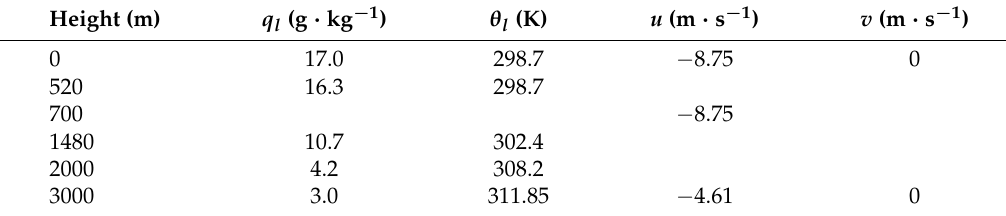
Table 2. Initial conditions set for the shallow cumulus convection